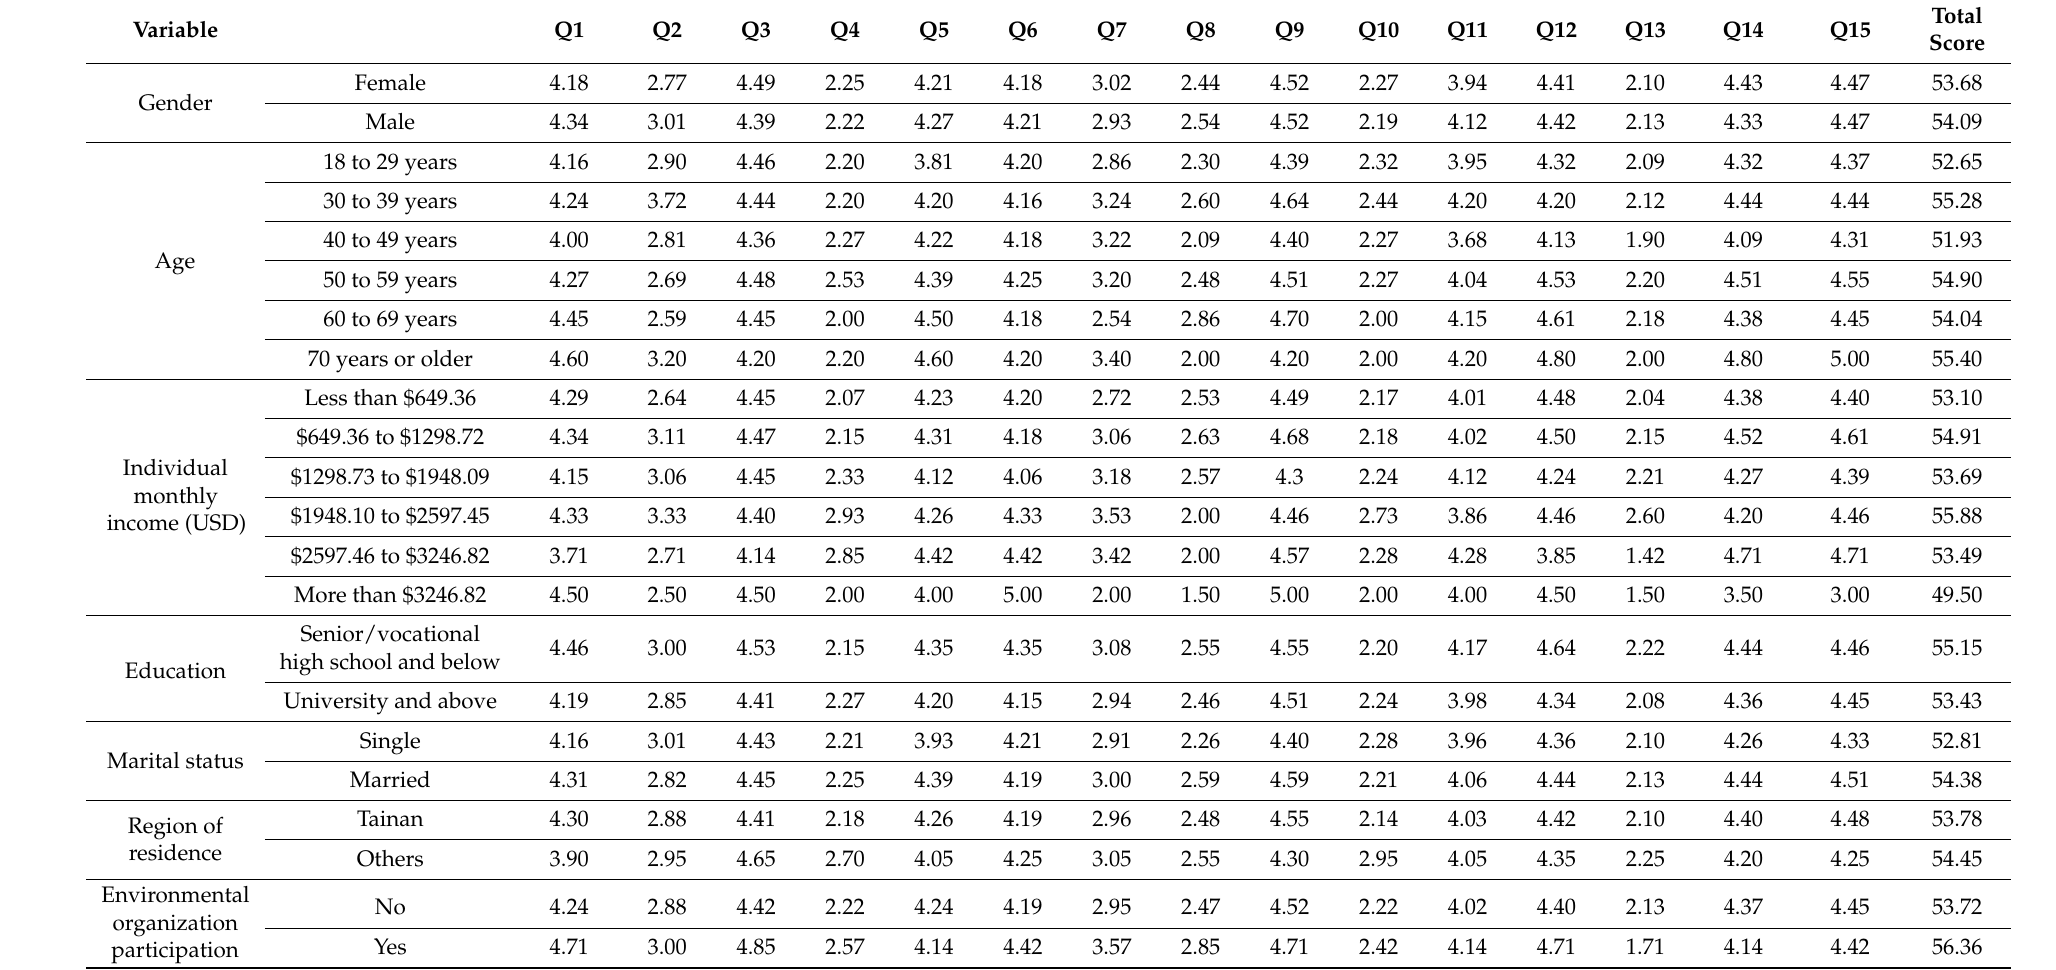
Table 4. Mean value of the NEP (for each item of part I in the